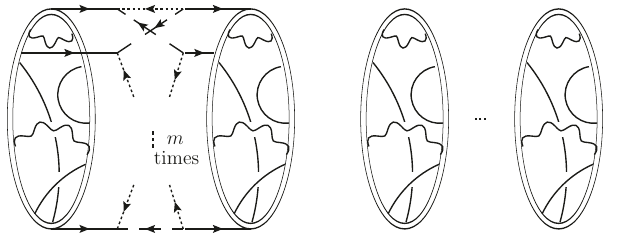
Figure 5 . Diagrams contributing with transcendentality ζ 2 m − 1 to the connected part of w ( q ) at finite N and generic values of the